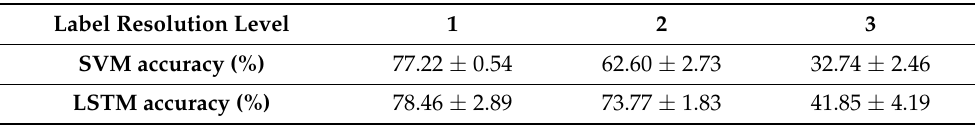
Table 6. Comparison of mean classification accuracy in SVM and LSTM classifiers for varying resolutions of activity label, using 5-fold cross-validation.